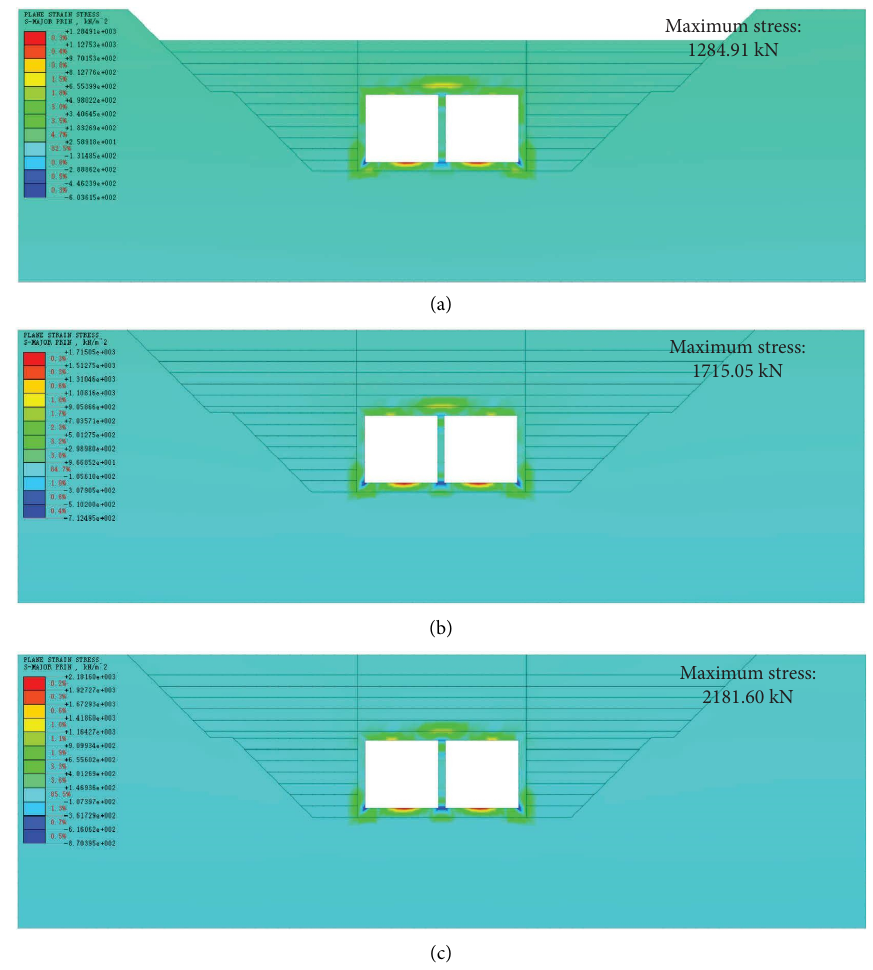
Figure 25: Change of backflling stress of roadbed and water-stable layer. (a) Road base backfll. (b) Backflling of water-stable pavement. (c) Consider the efect of river